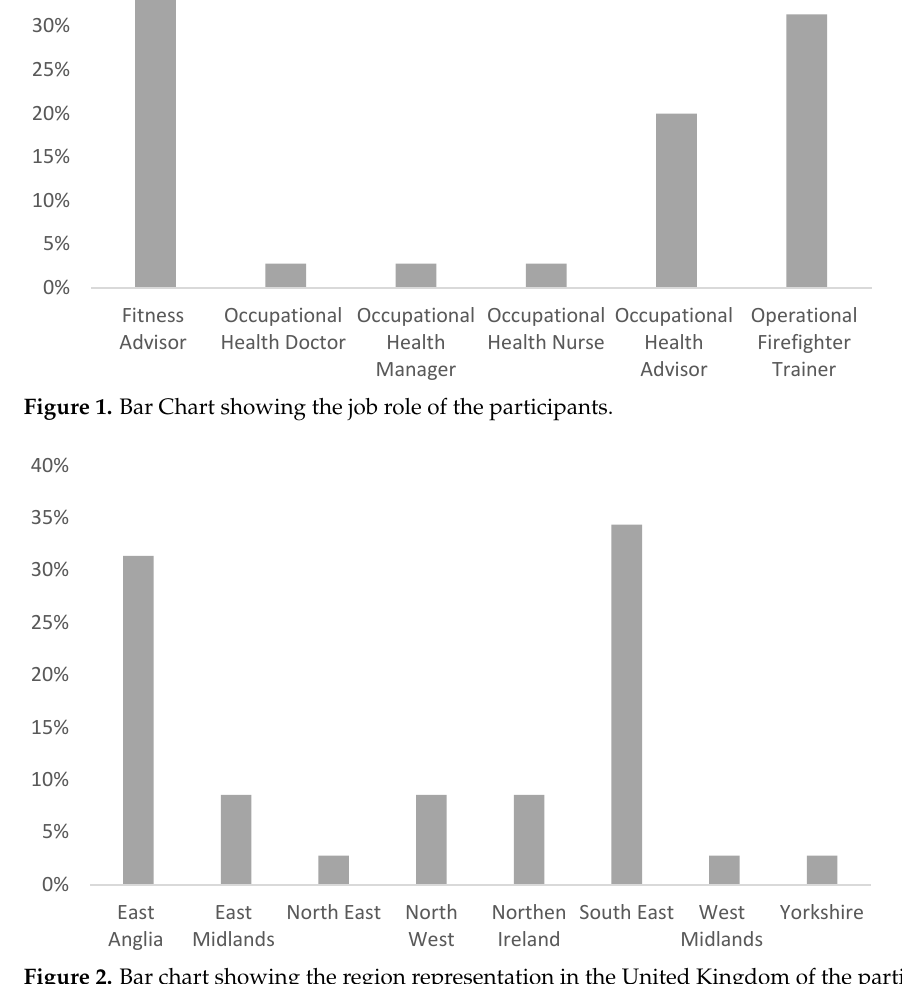
Figure 2. Bar chart showing the region representation in the United Kingdom of the participants. Table 1. Overall inter-rater reliability of all screening tests for both rating sessions. ICC = Intraclass correlation coefficients, CI = Confidence interval.